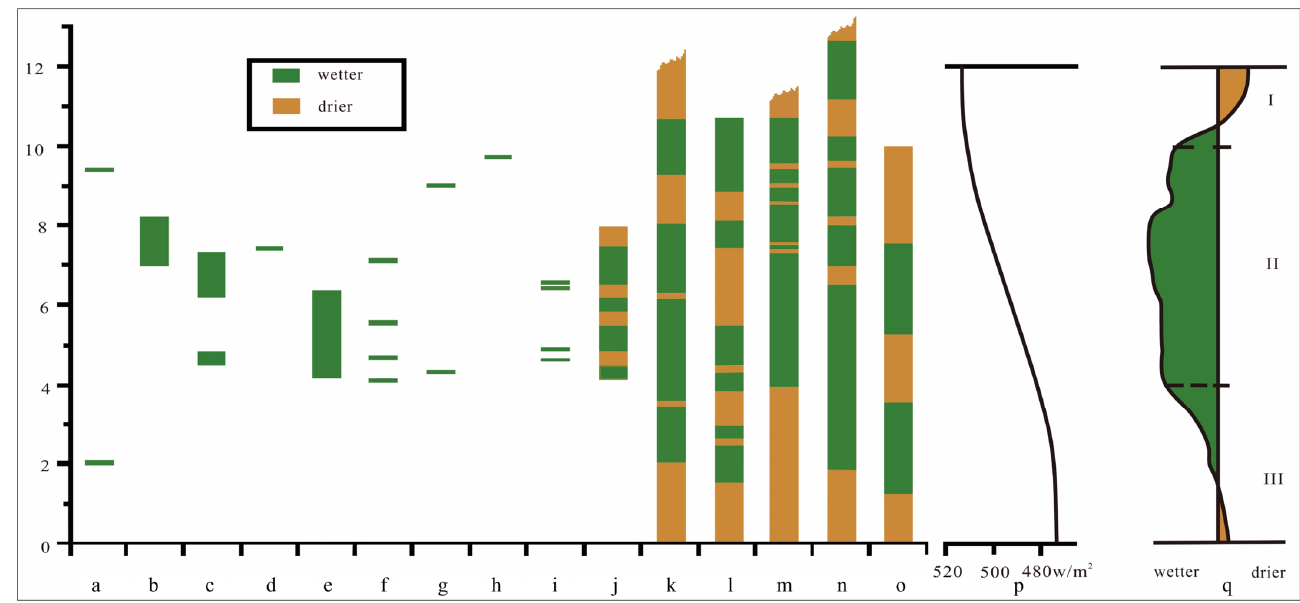
Figure 7. Distribution of dry and wet epochs during the Holocene period inferred from paleoenvironmental records in the Badanjilin Desert and other arid regions in China. (a) Calcareous cementations on the surface of sand dunes in the Badanjilin Desert, (b) Huhejilin Lake, (c) Zhalate Lake, (d) Sumujilin Lake, (e) Nuoertu Lake, (f) Shaobaijilang Lake, (g) Aomenjilin Lake, (h) Sayinwusu Lake, (i) Badan Lake, (j) Shugui Lake at the eastern edge of the Badanjilin Desert, (k) aeolian sequences in the southern edge of the Badanjilin Desert, (l) Juyanze Lake, the terminal lake of the Heihe River, (m) a terminal lake in the Tenggeli Desert, (n) Qinghaihu Lake in the northeastern Qinhai-Tibet Plateau, (o) Wulungu Lake at the northern edge of the Gurbantonggute Desert, (p) summer (May to September) solar insolation at 40° N, (q) synthesis of the above records (modified from [18]). The second is the drought events in the middle Holocene on the Alashan